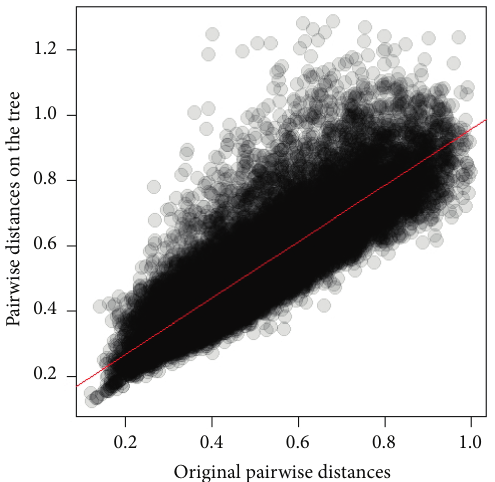
Figure 9: Validation of the error of the approximation of the neighbor-joining tree estimation applied over the Riemannian distance matrix of the 200 clusters. The linear regression R 2